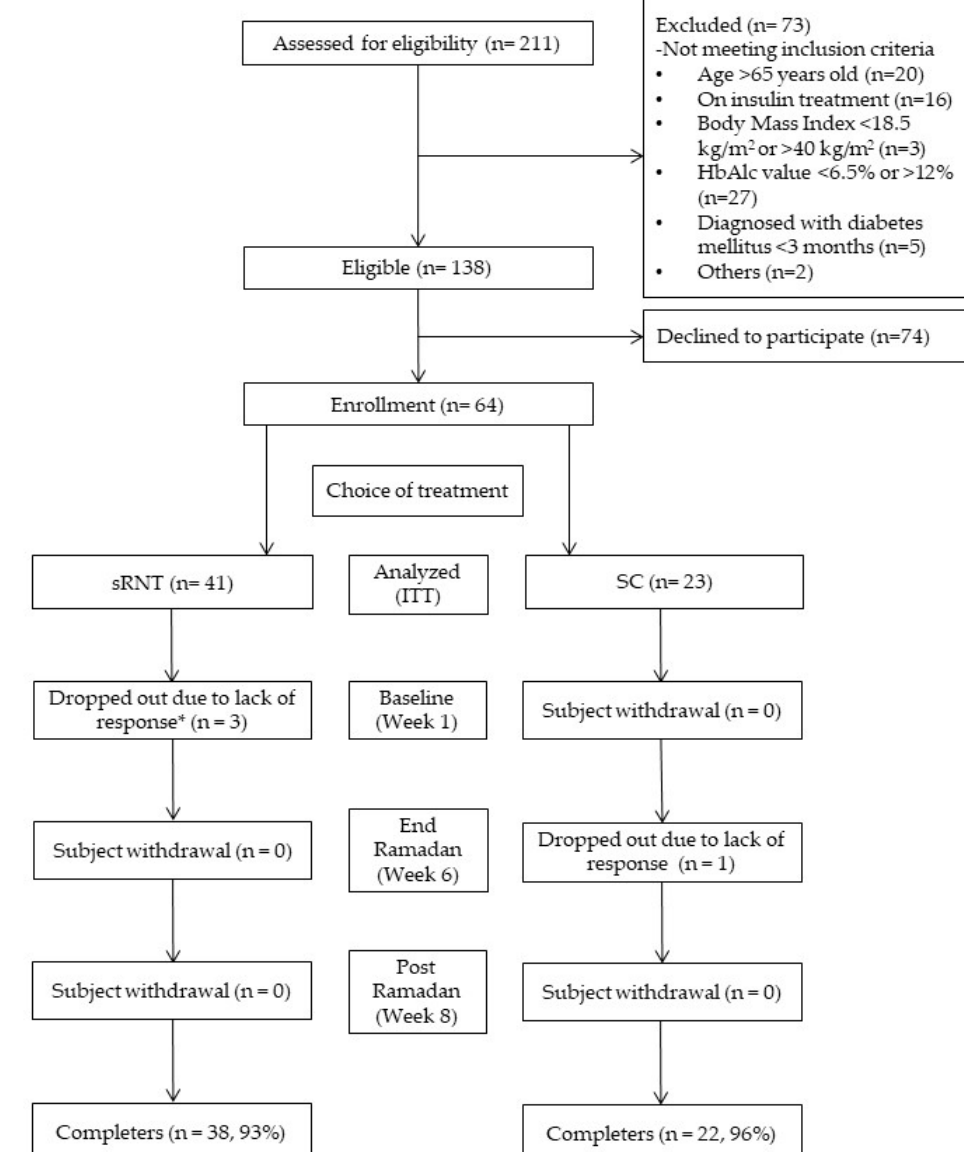
Figure 2. Screening and recruitment, * Three participants in structured Ramadan nutrition therapy, (sRNT) declined to participate before receiving the education. ITT, intention-to-treat analysis.